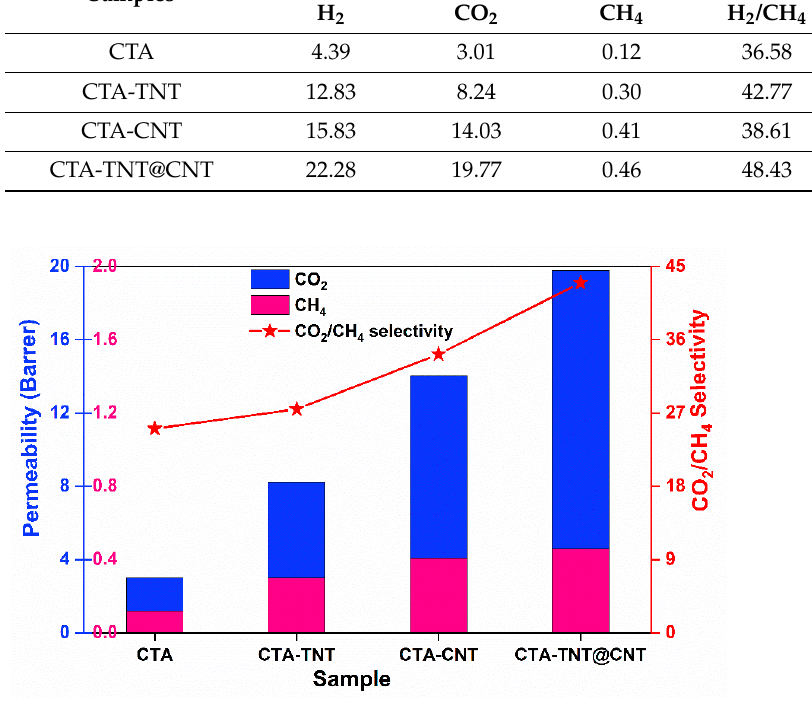
Figure 8. Single gas CO 2 and CH 4 permeability and selectivity plot of the synthesized membranes.